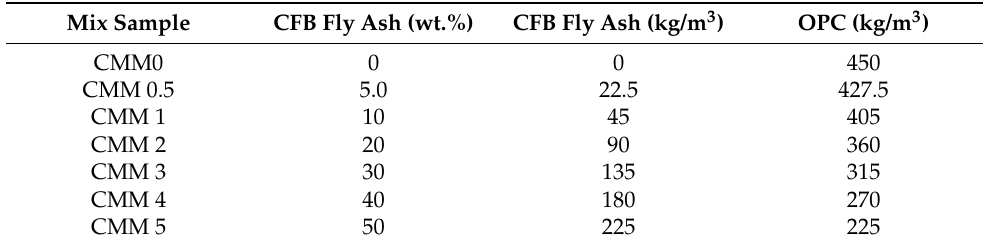
Table 2. Designed proportion of different CMM.